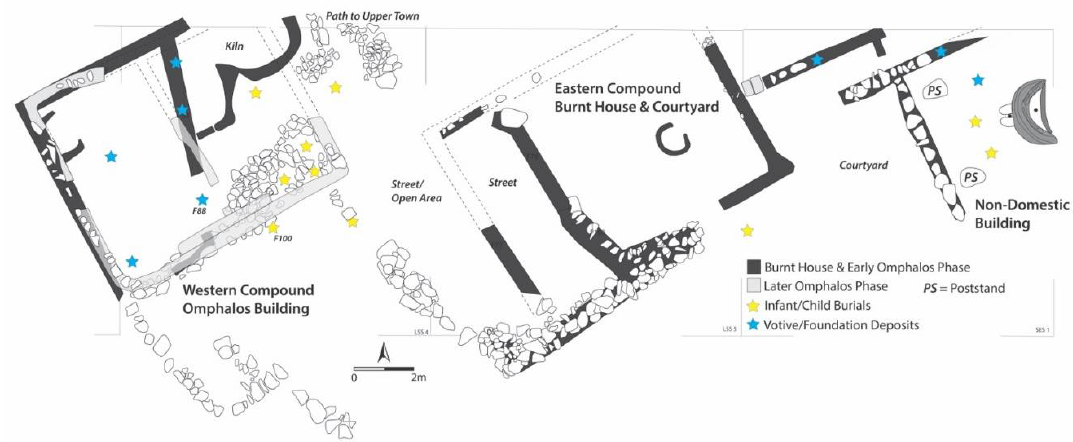
Figure 9. Plan of the Burnt House/Ompholos Building phase showing locations of burials and votive/foundation deposits.